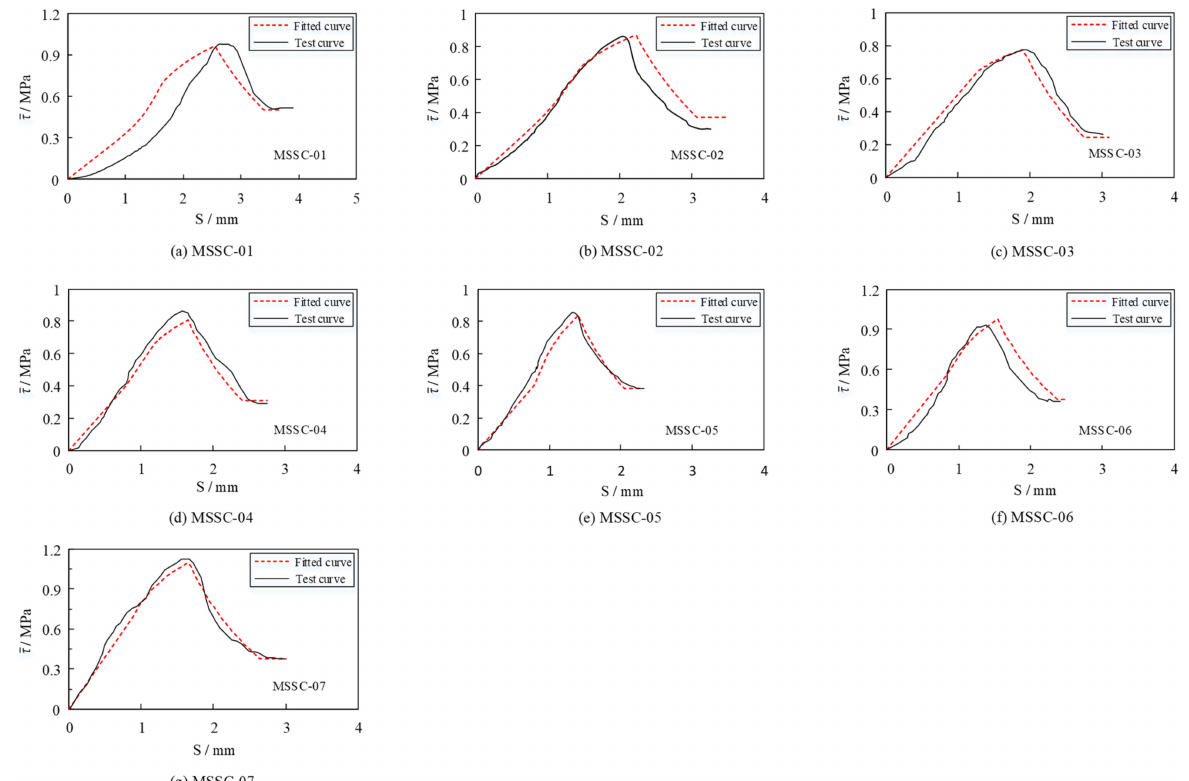
Figure 15. Comparison analysis of the test and fitted